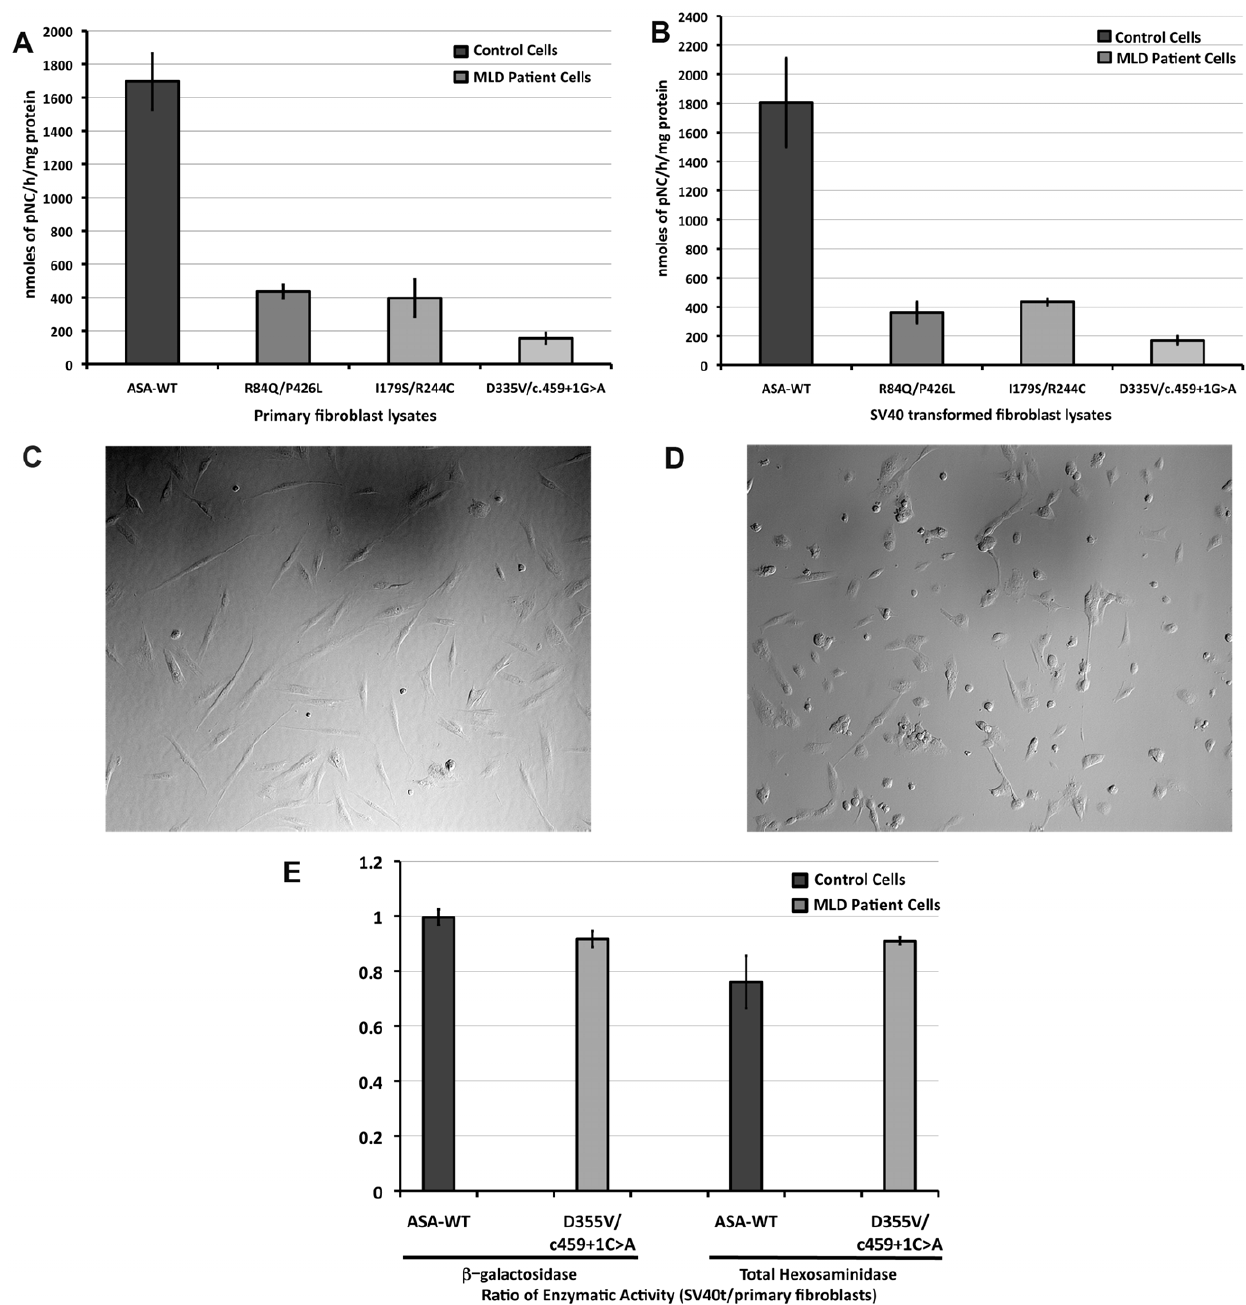
Figure 1. Biochemical and morphological comparison between primary and transformed cultured skin fibroblasts. Primary and SV40- transformed (SV40t) skin fibroblasts were culture in 75 cm 2 flasks up to confluence before being harvest to obtain cell lysates to perform ASA activity assays. ( A ) ASA enzymatic activity of primary skin fibroblast, control with wild type ASA (ASA-WT) and three MLD patient cell lines with different ARSA mutations. Each of these cell lines carries a previously described mutant ASA with a residual enzymatic activity (I179S, P426L, D335V). ASA activity is expressed in nmoles of pNC per hour and standardized by protein concentration. ( B ) ASA activity from SV40t fibroblasts showed comparable ASA activity with primary cell lines. ( C ) Cell morphology of primary skin fibroblasts showed the classical fusiform shape. The SV40t counterparts ( D ) show distinguishable polygonal shape. ( E ) The ratio of enzymatic activity of two other lysosomal enzymes beta-galactosidase and total beta- hexosaminidase are shown. Both the control (ASA-WT; dark gray) and MLD patient cells (ASA-D355V/c.959 + 1C . A; light gray) showed a ratio close to 1. higher absorbance signals than primary fibroblasts (Fig.S2). SV40t between controls (ASA-WT) and a selected MLD patient cells were then cultured in white solid-bottom 384-well plates, fibroblast cell line (ASA-I179S), which shows the highest ASA assayed with pNCS substrate and fluorescence was measured at residual activity (Supporting Information S1 and Fig.S1). SV40t excitation/emission pair 525/598 nm in a multiple-well plate fibroblasts from both controls and the MDL patient generate